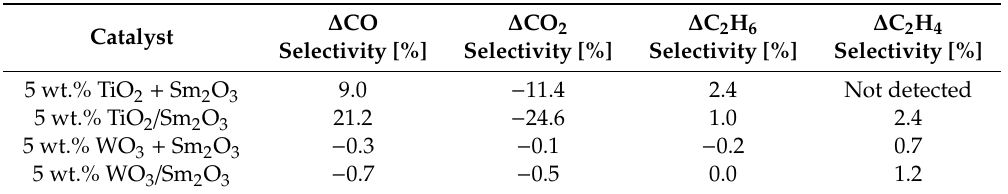
Table 1. E ff ect of UV-LED irradiation on the selectivity for each of the products when using the binary catalysts in the present